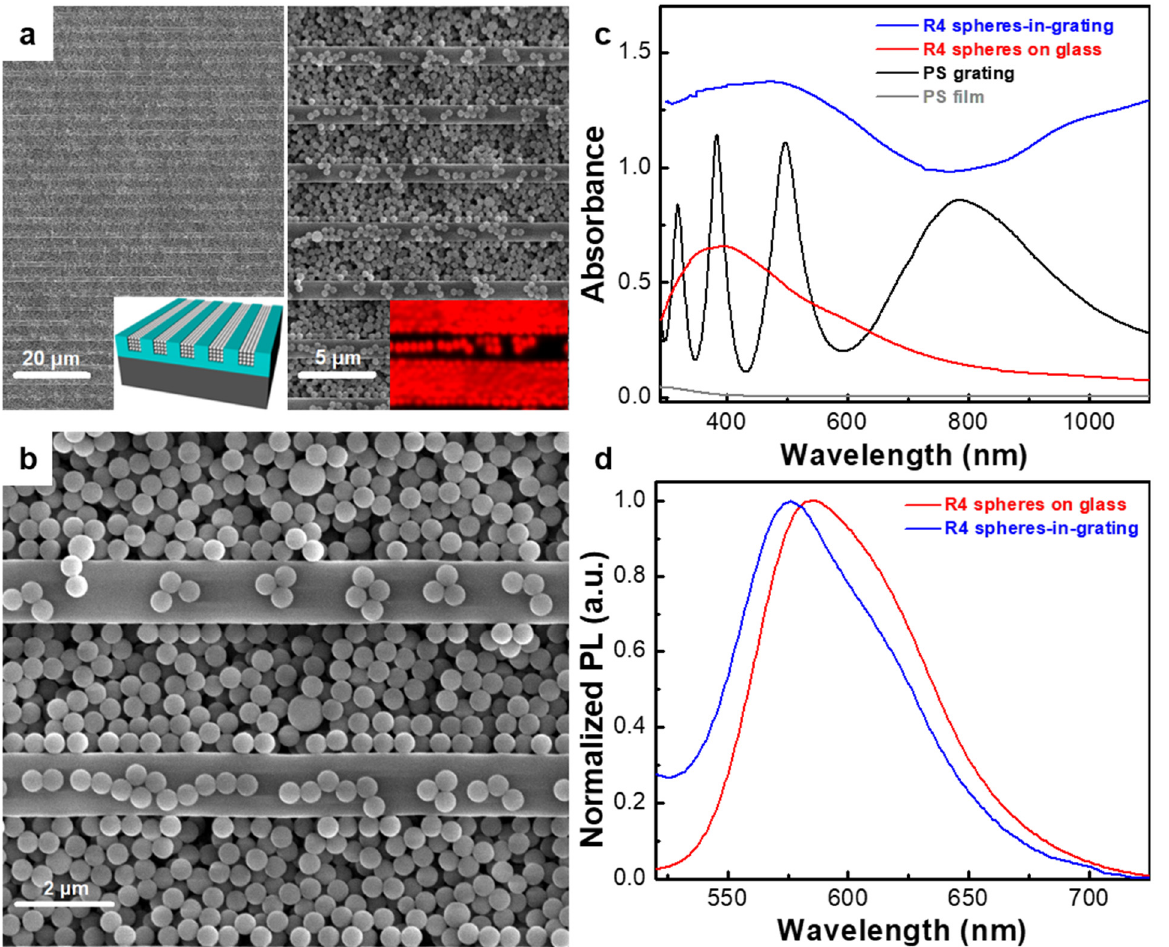
Figure 1. ( a , b ) SEM images of different magnification depicting Nile-red-dyed PS spheres (R4) in periodic PS grooves of a width of 2.5 µm and a depth of 2 µm. While the inset on the left schematically depicts the expected sphere-in-grating assembly, the inset on the right represents a fluorescence image of the obtained assembly. ( c ) Absorption spectra comparing an unpatterned PS film both with a PS grating before and after filling with R4 spheres, and with R4 spheres spin-cast on glass. ( d ) Normalized PL spectra exhibiting a blueshift from 583 nm to 575 nm when comparing R4 spheres spin-cast on glass to those incorporated in the grating. An excitation wavelength of 400 nm was used to record the PL spectra.